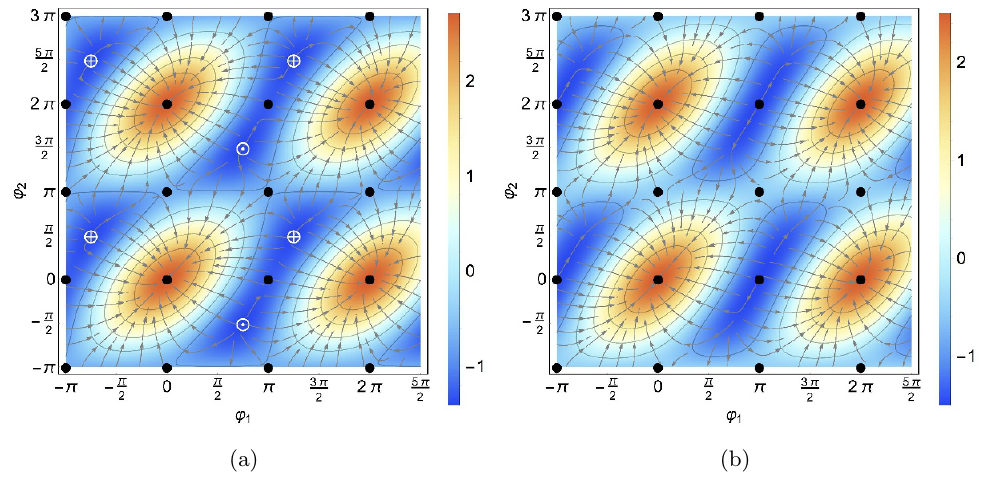
Figure 6 . SU(3) vacua and the pre-potential: (a) case I, (b) case II. Black dots represent vacua (7.1), (cid:12) stand for vacua (7.2) with the upper sign and (cid:8) for vacua (7.2) with the lower sign. The arrows represent the r (cid:17) U -(cid:13)ow.